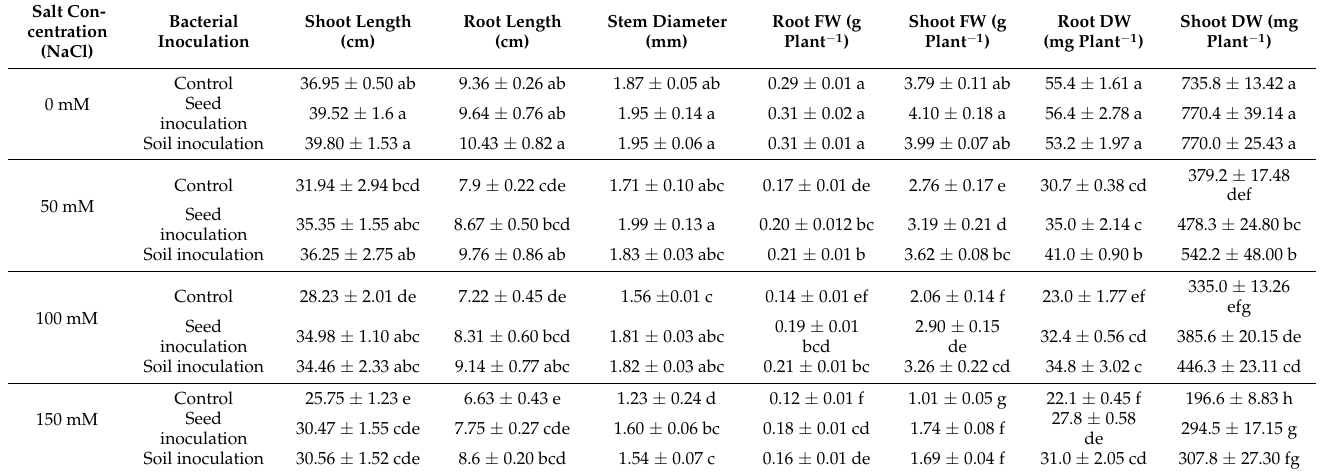
Table 1. Effect of Bacillus subtilis inoculation on growth attributes of soybean ( Glycine max cv. BARI Soybean-5) under different levels of NaCl. Values in a column are mean ± SD. Different letters on each bar indicate significant differences among the treatment after applying a Tukey’s HSD test at p ≤